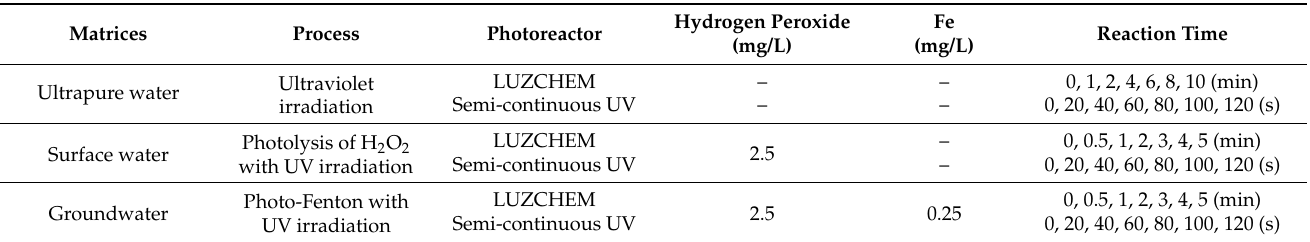
Table 2. Experimental conditions applied in the degradation studies of terbuthylazine in different water